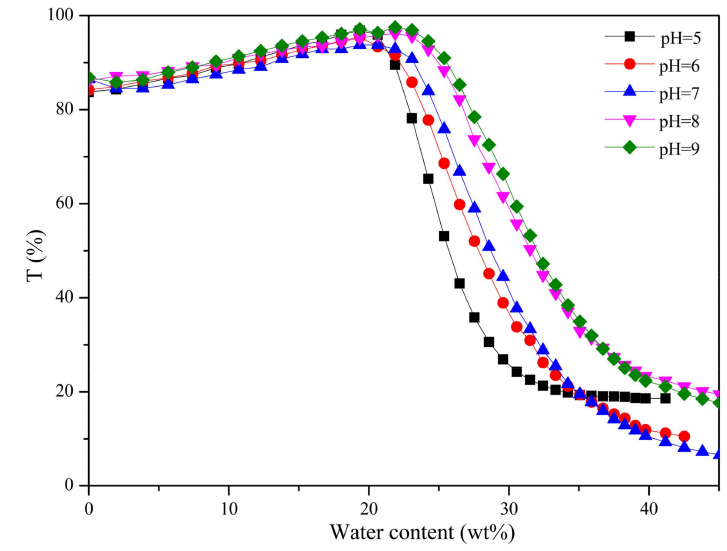
Figure 6. Relationships between light transmission at 267 nm and water content of mPEG 43 - b -P[(TMC-C) 20 -TMC 20 ] for the self-assembly process at different pH levels.